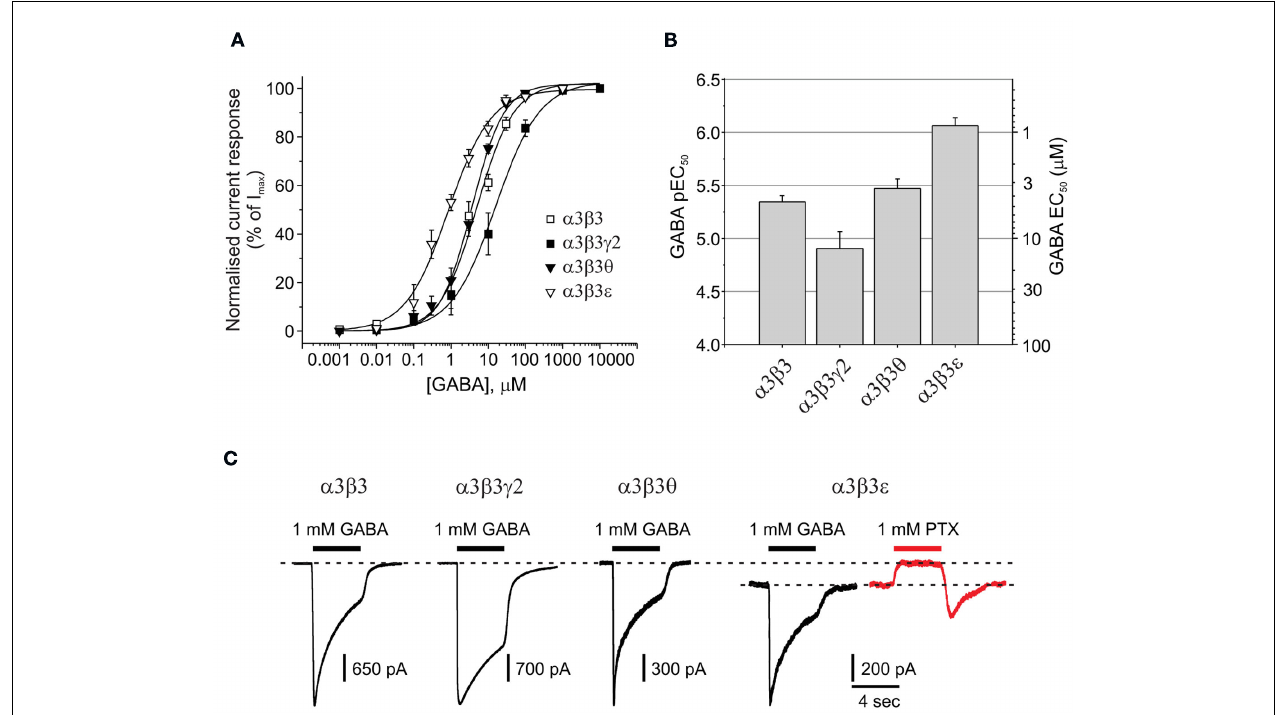
FIGURE 4 | Impact of θ or ε on GABA potency and spontaneous channel opening. (A) GABA concentration response curves for α 3 β 3, α 3 β 3 γ 2, α 3 β 3 θ , and α 3 β 3 ε GABA A receptors expressed in HEK293 cells ( n = 20). (B) Bar chart of pEC 50 (mean ± SEM) and EC 50 values for α 3 β 3x receptors. (C) Membrane